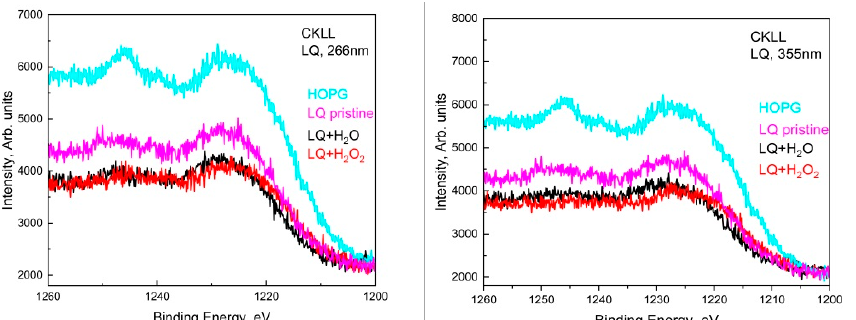
Figure 5. Auger spectra of LQ+H 2 O and LQ+H 2 O 2 sediments for both wavelengths, 266 nm and 355 nm, compared to LQ pristine and HOPG.